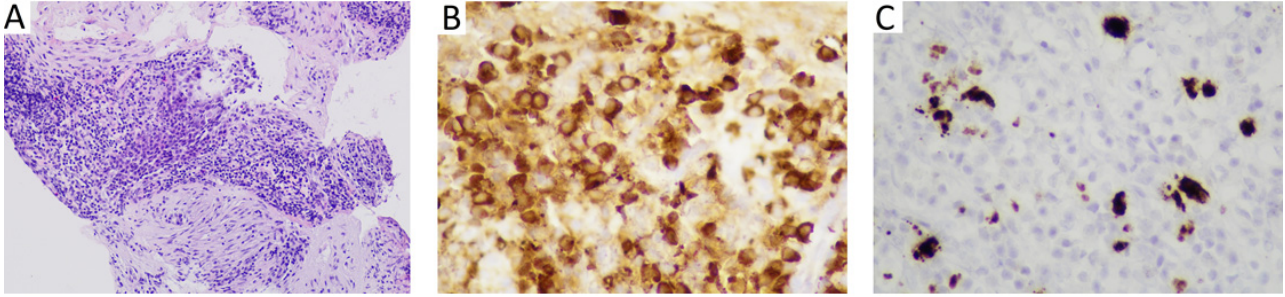
Figure 5. Biopsy of left mastoid—case 2. Hematoxylin and eosin (H&E). Original magnification: A-D 100 × , E 200 × . ( A ) Fibrous tissue with (top) foci of dense lymphoplasmacytic inflammation and (bottom) storiform fibrosis (H&E, original magnification 100 × ). ( B ) Total IgG and ( C ) IgG4 plasma cell population (original magnification 400 ×